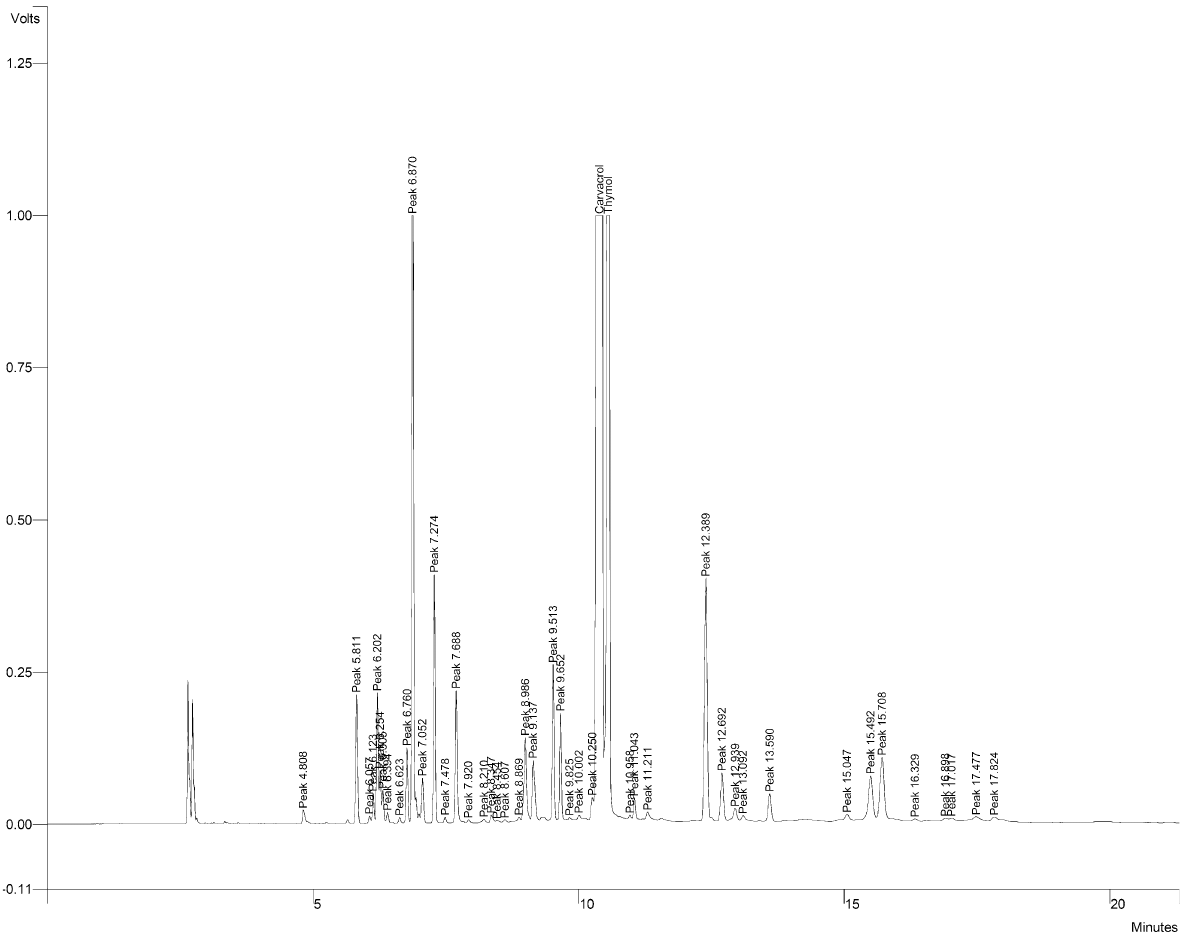
Fig. 2 Gas chromatogram of Zataria multiflora oil extract showing thymol and carvacrol as the major constituents